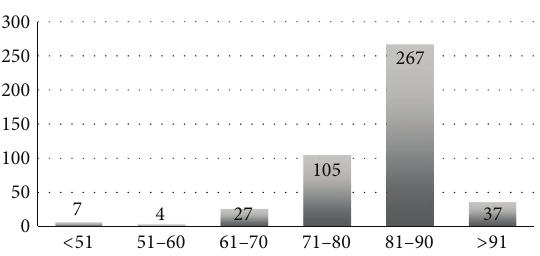
Figure 3: Distribution of lime users (repartition is a totally obscure